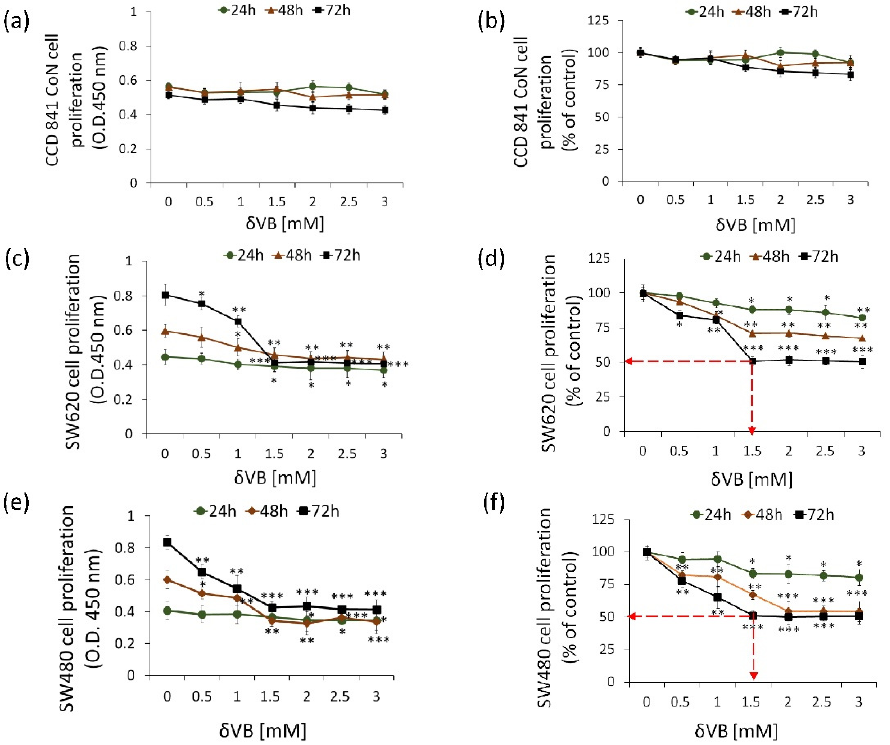
Figure 1. Effects of δ VB on SW620 and SW480 cell proliferation. ( a , b ) CCD 841 CoN, ( c , d ) SW620 and ( e , f ) SW480 cells were treated with increasing concentrations of δ VB (0–3 mM) for 24, 48 and 72 h. The IC50 in SW620 and SW480 was determined at 72 h incubation with 1.5 mM δ VB and represented as red dotted arrows. Control cells were grown in medium containing the same volume of HBSS-10 mM Hepes. Cell proliferation inhibition was assessed using Cell Counting Kit-8 assay (Donjindo Molecular Technologies, Tokyo, Japan). Values represent the mean ± SD or the % of control of four independent experiments. * p < 0.05 vs. Ctr; ** p < 0.01 vs. Ctr; *** p < 0.001 vs. Ctr.